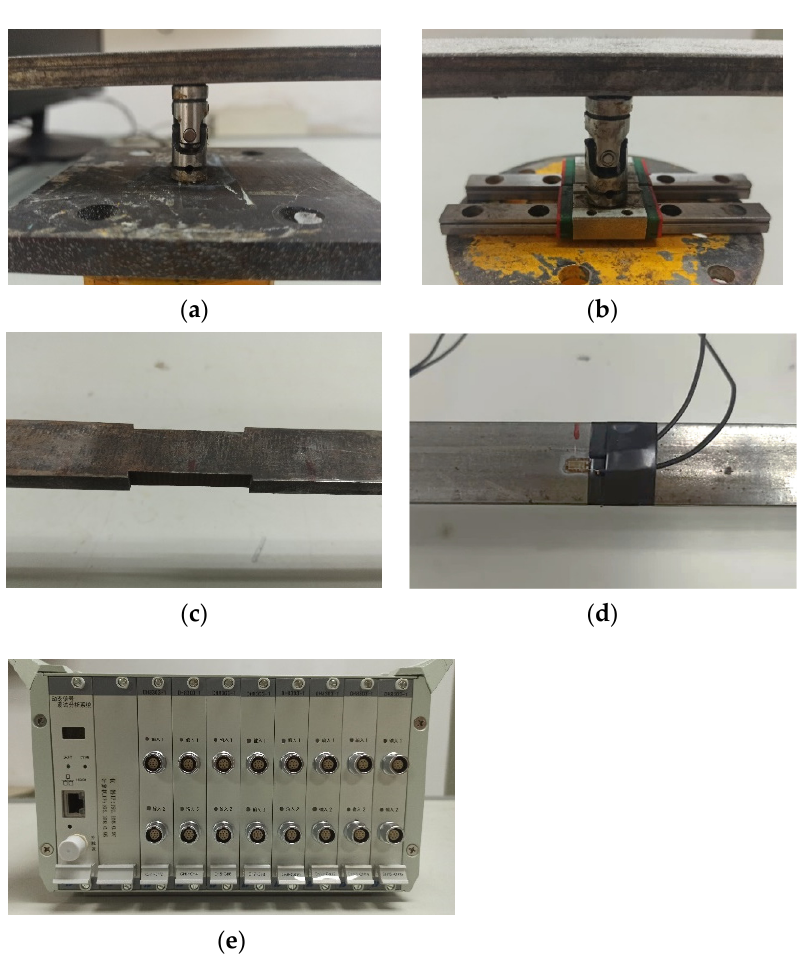
Figure 10. Experimental instruments: ( a ) fixed hinge support; ( b ) sliding hinge support; ( c ) rectan- gular notches; ( d ) strain gauge; ( e ) DH8303 dynamic signal test and analysis system. lar notches; ( d ) strain gauge; ( e ) DH8303 dynamic signal test and analysis Table 3. Specifications of the strain gauge.